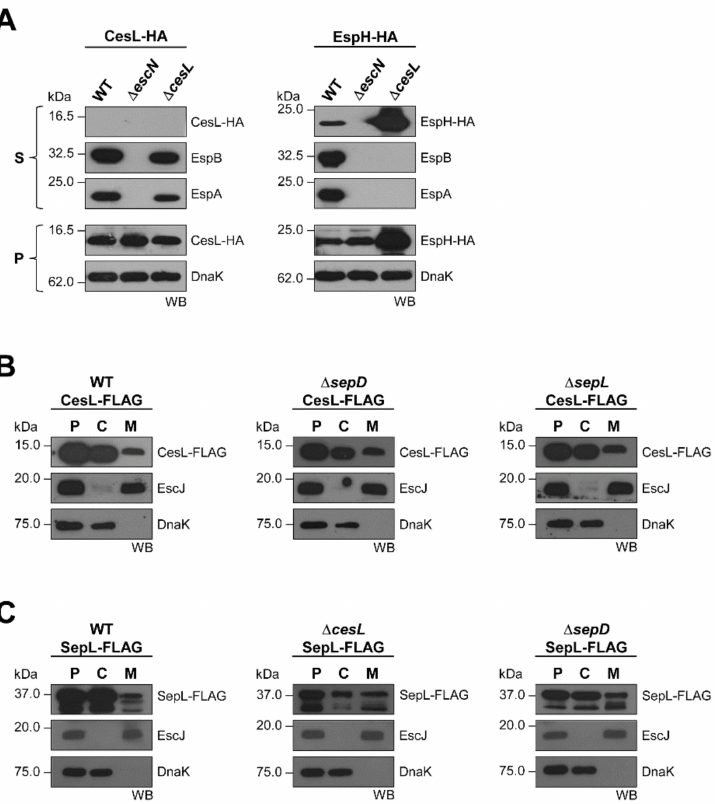
Figure 5. CesL and SepL associate with the membrane independently of their molecular switch interacting partners. ( A ) Secreted proteins (S) and whole-cell lysates (P) of wild-type EPEC (WT), ∆ escN and ∆ cesL strains harboring plasmid pMHcL producing CesL-HA (left panel), or plasmid pJHeH producing EspH-HA (right panel), were subjected to SDS-PAGE and immunoblotting with an anti-HA antibody. The presence of EspB and EspA in the supernatant and that of DnaK in the bacterial pellet was also analyzed by immunoblotting. ( B , C ) Wild-type EPEC (WT), ∆ sepD and ∆ sepL strains expressing chromosomally encoded ( B ) CesL-FLAG or ( C ) SepL-FLAG. EPEC strains were grown under T3S-inducing conditions and fractionated into cytoplasmic (C) and membrane (M) fractions. Whole-cell lysates (P) were loaded as a control. EscJ and DnaK were used as cytoplasmic and membrane protein controls, respectively. Equal amounts of each fraction were probed using antibodies against the FLAG tag, EscJ, or